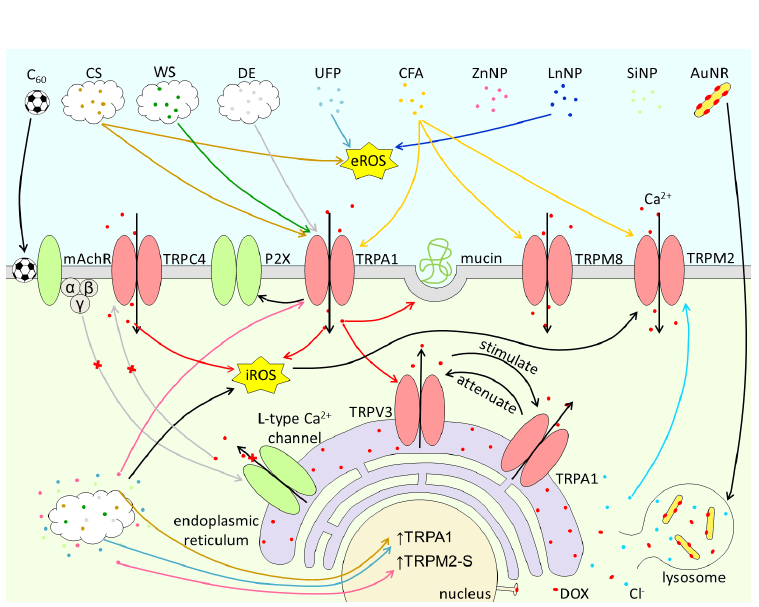
Figure 4. Graphical summary of the activation of TRPA1, TRPC4, TRPM2, TRPM8 and TRPV3 channels by C 60 fullerenes, cigarette smoke (CS), wood smoke (WS), diesel exhaust (DE), ultrafine ambient particles (UFP), coal fly ash (CFA), zinc NPs (ZnNP), lanthanide NPs (LnNP), silica NPs (SiNP) and DOX-coated gold nanorods (AuNP).